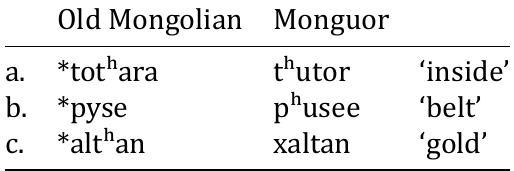
Table 3: Regressive aspiration metathesis in